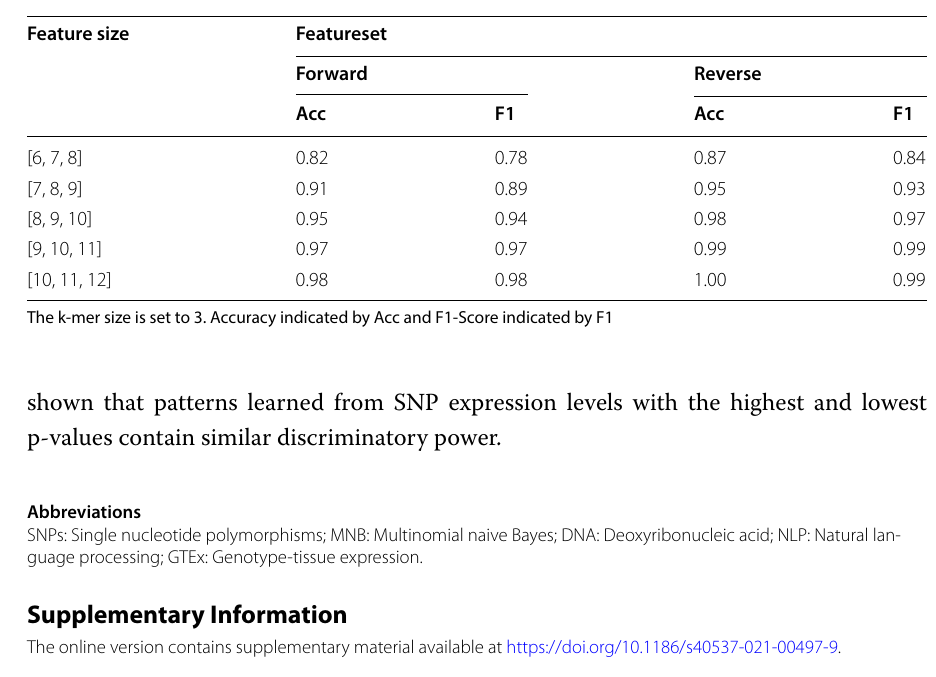
Table 4 Effects of varying feature size on a dataset that comprises of all the common genes that exist across of all the 49 human tissues Feature